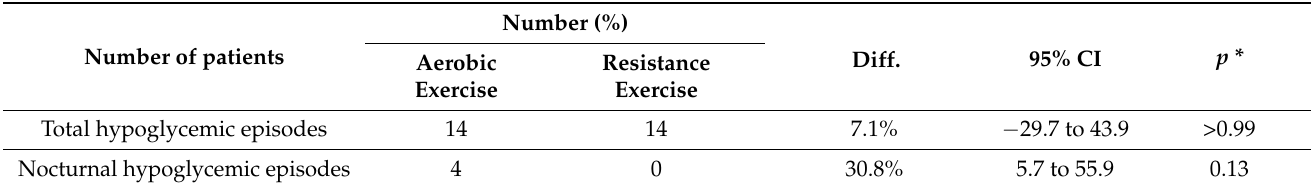
Table 5. Differences in the number of total and nocturnal hypoglycemic episodes 24 h after training, depending on the type of